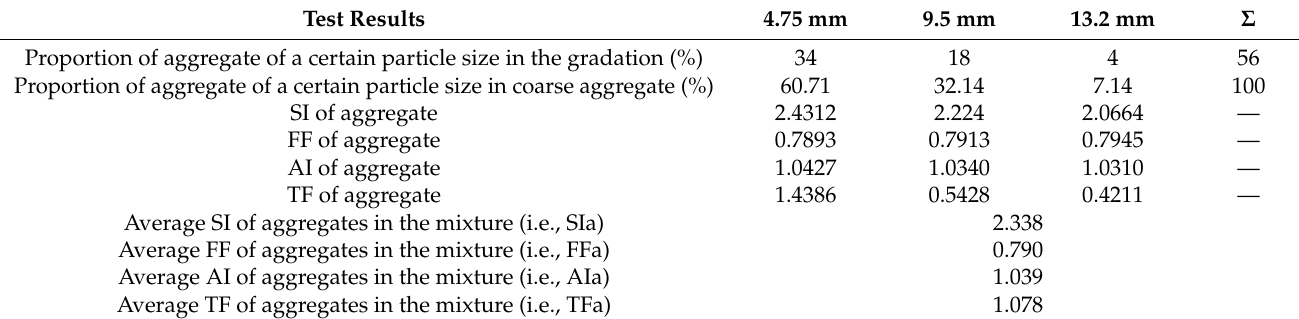
Table 5. Calculation method of aggregate geometrical features in the mixture.